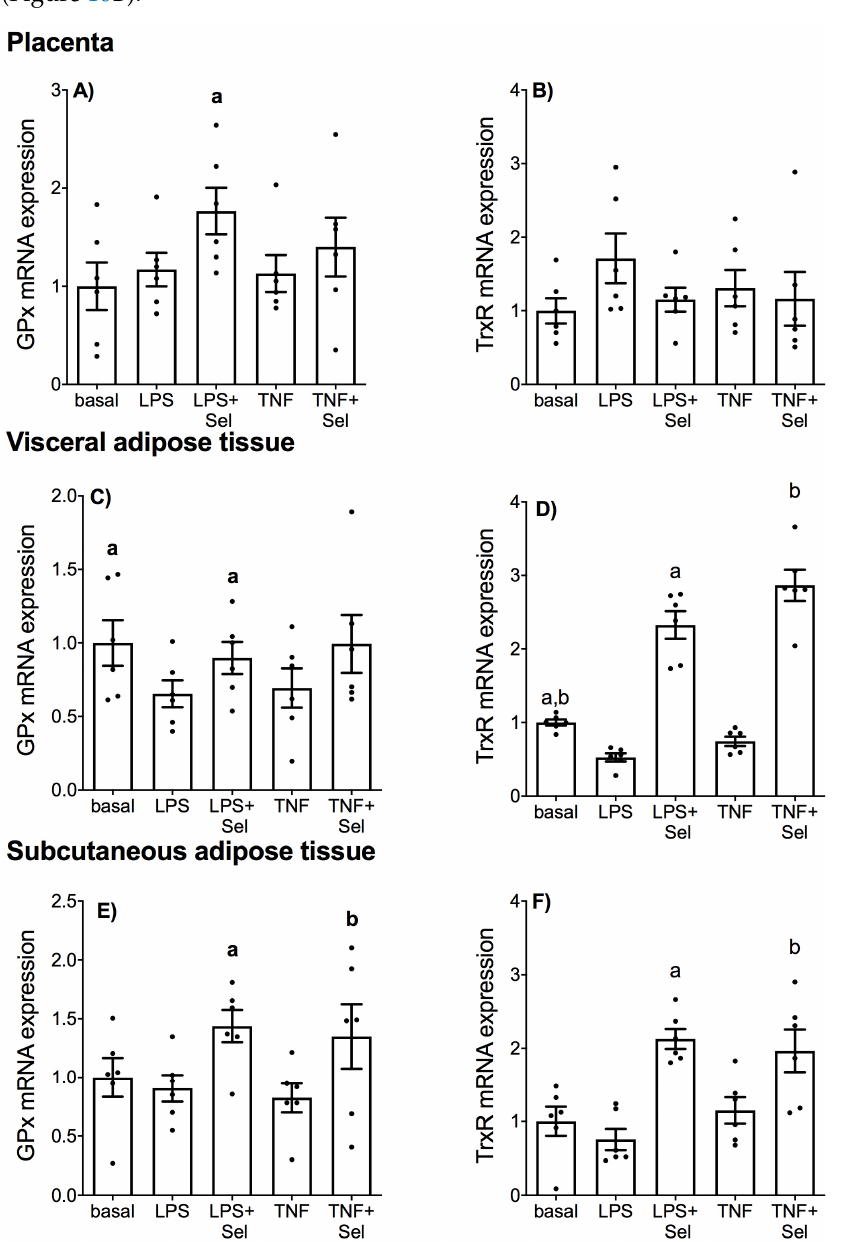
Figure 10. Effect of selenium on antioxidant selenoenzyme expression in human placenta, and VAT and SAT from pregnant women. ( A , B ) Placenta ( n = 6 patients), ( C , D ) VAT ( n = 6 patients) and ( E , F ) SAT ( n = 6 patients) were incubated with or without 10 µM sodium selenite (Sel) for 1 h and then stimulated with 10 µg/mL LPS or 10 ng/mL TNF- α for a further 20 h. GPx and TrxR mRNA